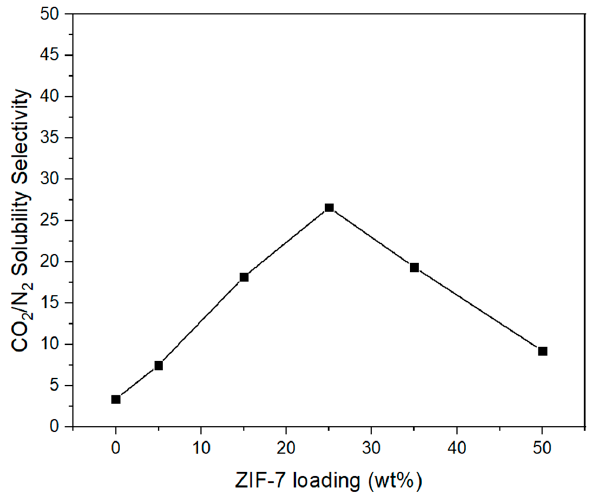
Figure 19. CO 2 /N 2 solubility selectivity of Pebax ‐ 2533/ZIF ‐ 7 composite membranes.